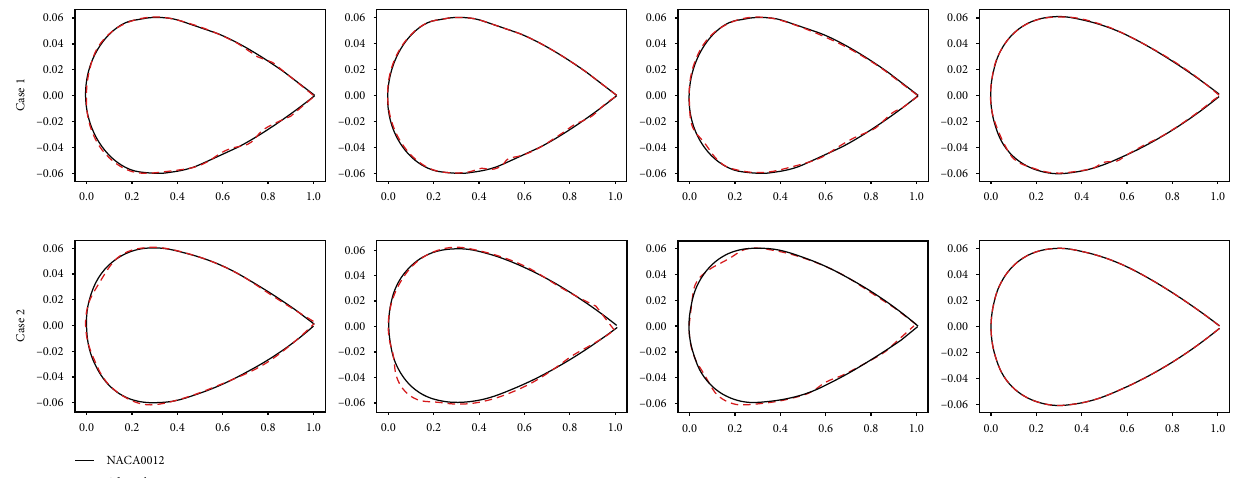
Figure 10: NACA 0012 airfoil and its adjustments that enlarges the output of the speci fi c neuron in the fully connected layer. Di ff erent columns show the results of di ff erent